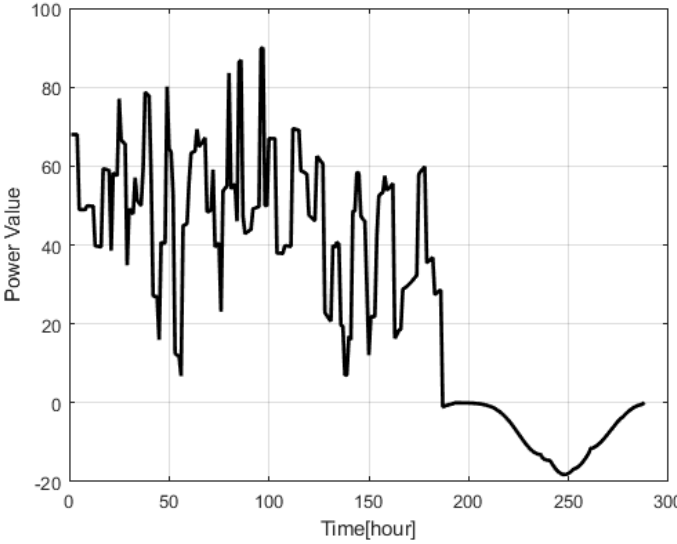
Figure 6. Power Grid Simulation 1.